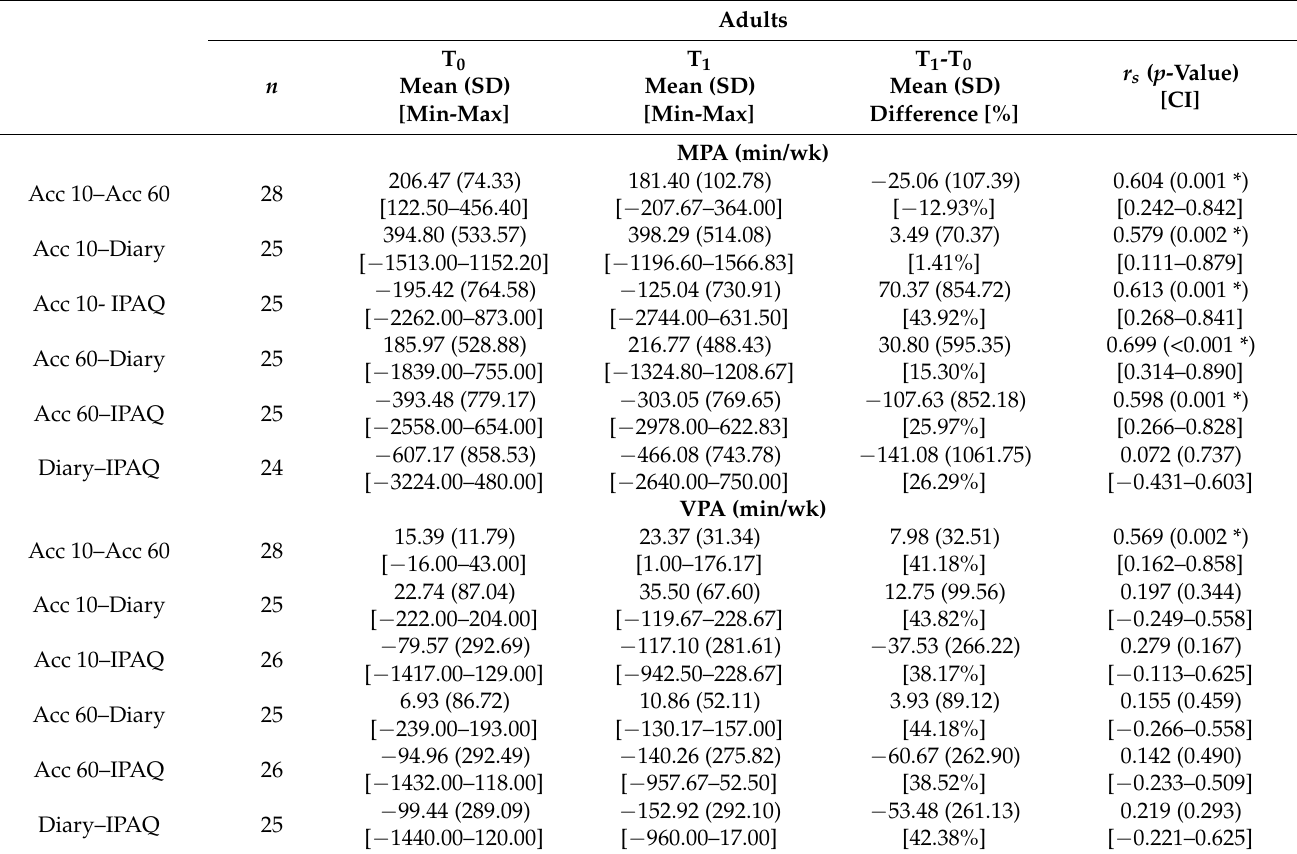
Table 2. Results of stability of differences calculated by Spearman’s rho ( r s ) for adults. Displayed are the number of participants ( n ), mean differences between the measurement tools (Mean), their standard deviations (SD), and their minimum (Min) and maximum (Max) values at two measurements three weeks apart (T 0 and T 1 ) as well as the differences in the error between T 1 and T 0 as mean, SD and percentage (%). Additionally, r s with corresponding p -value (* for p < 0.05) and 95% confidence interval via bootstrapping (CI) for differences between the measurement tools: accelerometry with 60 s epoch length (Acc 60) and 10 s epoch length (Acc 10), physical activity diary (Diary), the International Physical Activity Questionnaire (IPAQ) for moderate (MPA) and vigorous (VPA) physical activity.